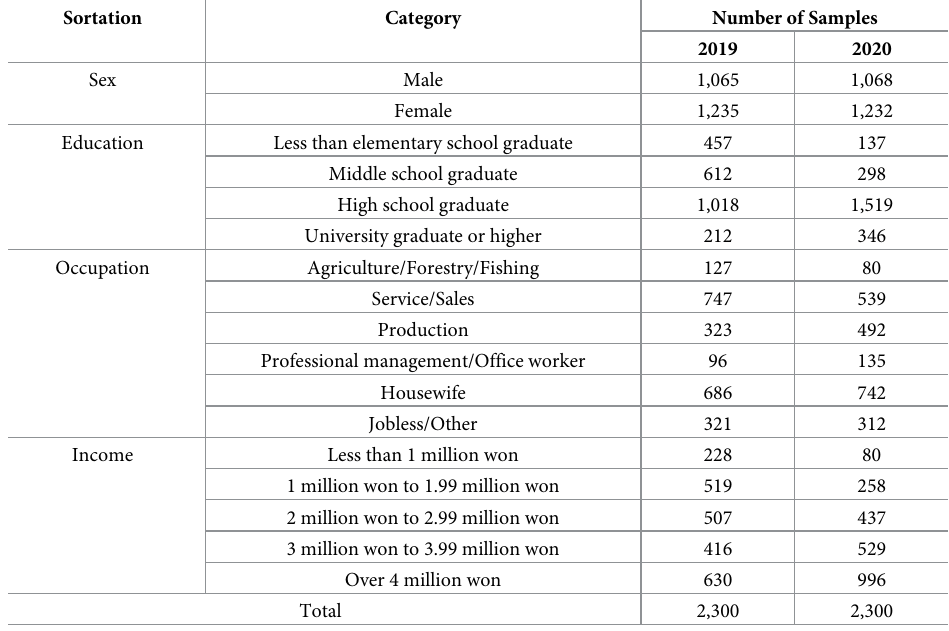
Table 2. Demographic